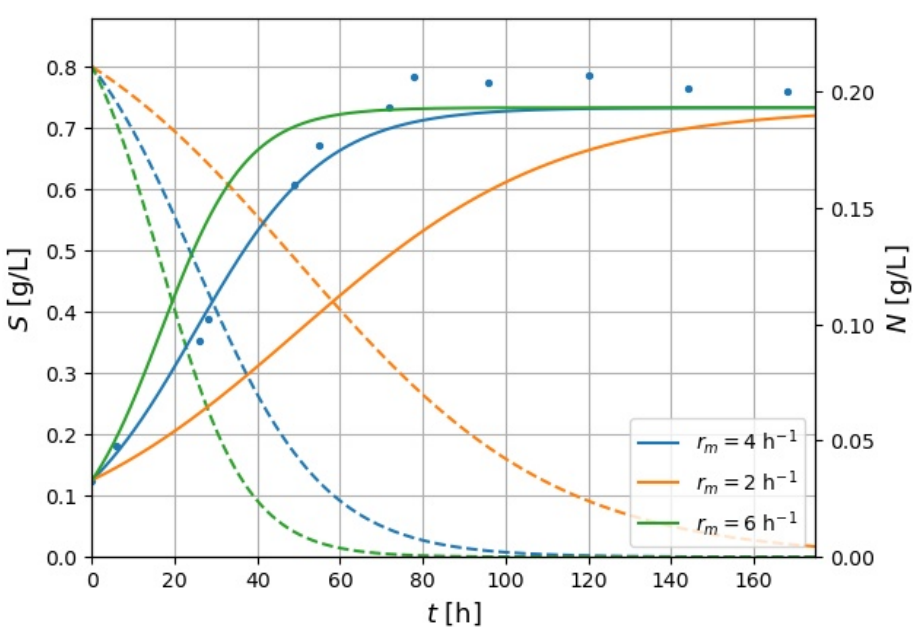
Figure 5. Sensitivity of bacterial concentration on the inner parameter γ ( a = 60 g/L and r m = 4 h − 1 ). Blue dots correspond to experimental data.